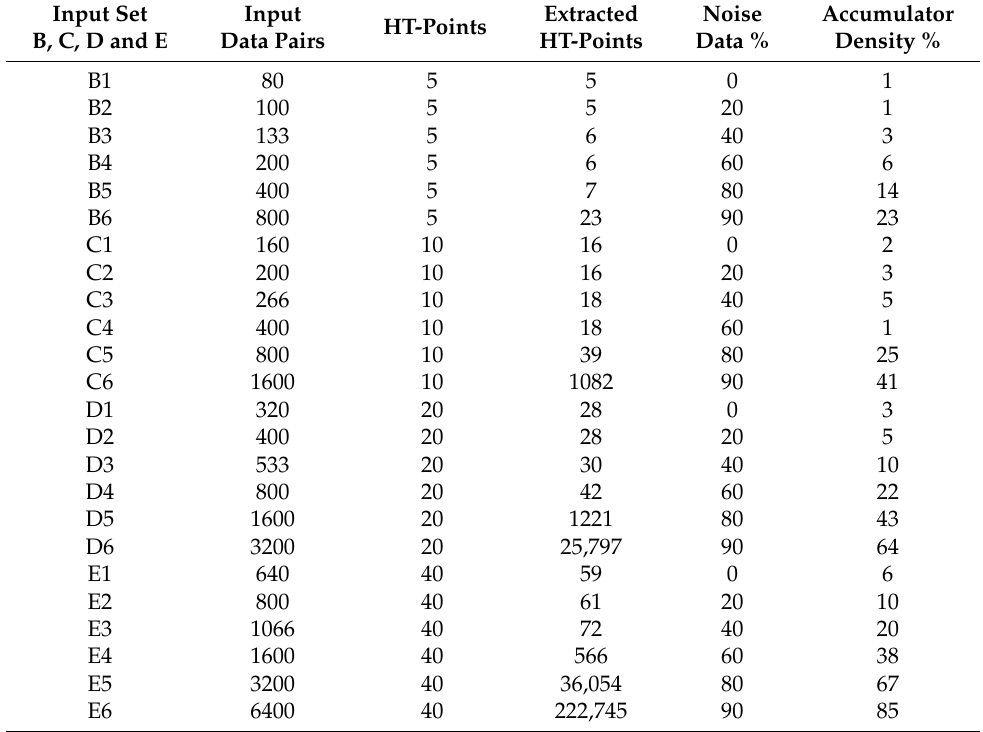
Table 2. Summary table for an SW